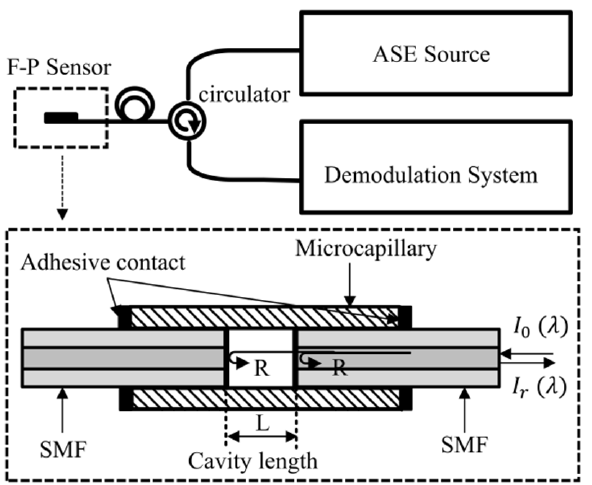
Figure 1. Fiber optic extrinsic Fabry-Perot interferometer demodulation system. (ASE: amplified Sspontaneous emission; F—P Sensor: Fabry-Perot sensor; SMF: single-mode fiber; R: optical fiber end reflectivity; I 0 ( λ ): incident light intensity; I r ( λ ): intensity of reflected light).